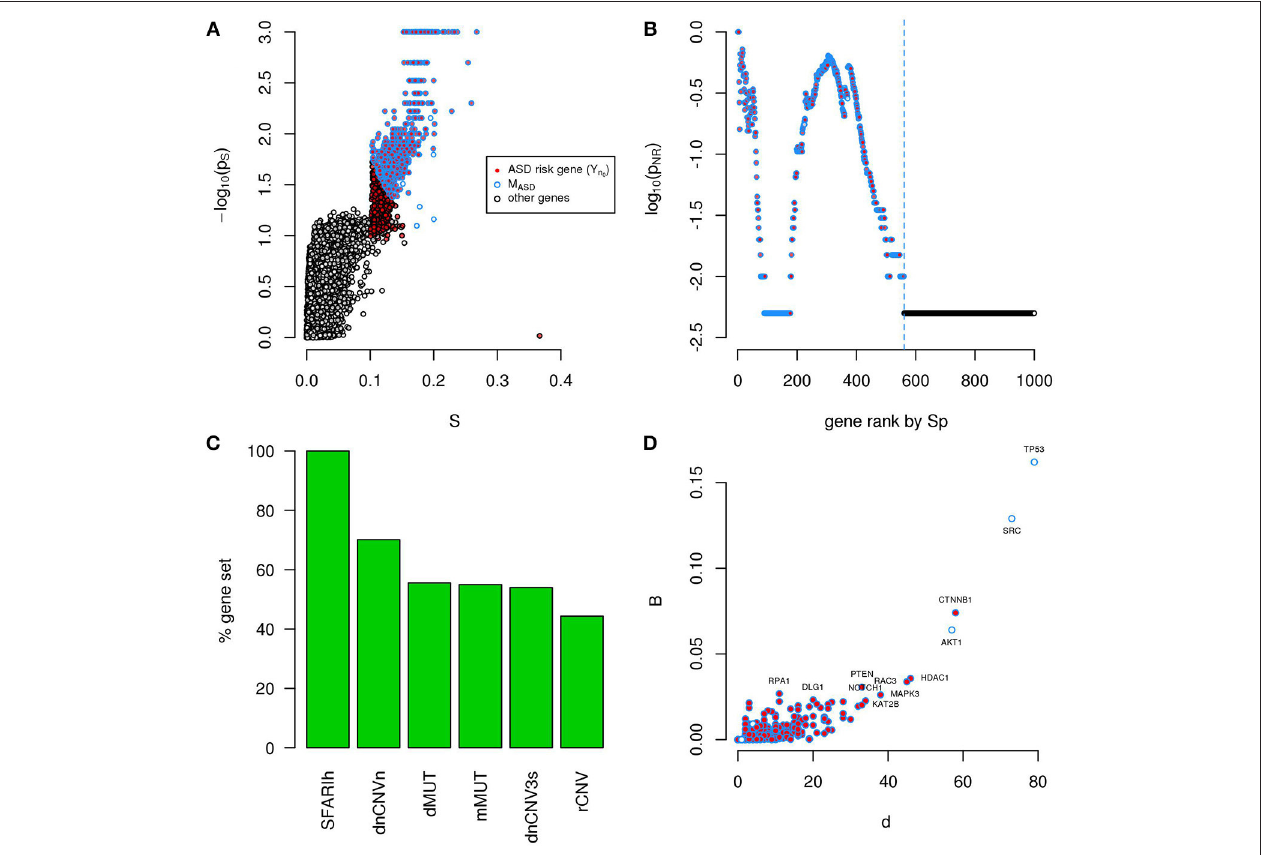
FIGURE 6 | A significantly connected gene module based on ASD risk genes from 6 sources. The network-diffusion based analysis of 956 ASD risk genes from 6 sources (red) leads to the definition of a significantly connected gene module (M ASD ) of 561 genes (blue border). (A) Network smoothing index ( S ) and corresponding p -value ( p s ). (B) For each rank n (horizontal axis), the estimated p -value ( p NR ) that quantifies the significance of the gene network defined by the genes ranked up to the n -th rank is reported on the vertical axis. (C) Percent of ASD genes of original lists included in M ASD . (D) Number of interactions ( d ) and betweenness (B) of genes in M ASD . (A–D ) G : all genes included in the PPI